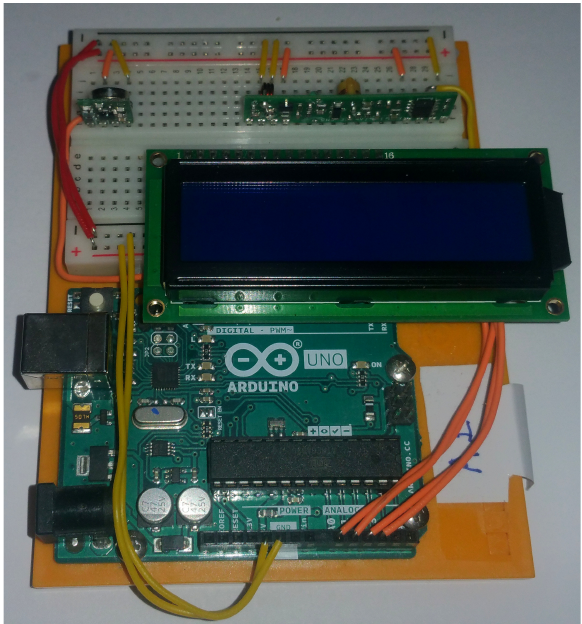
Figure 2. A device of the considered system enhanced with an LCD